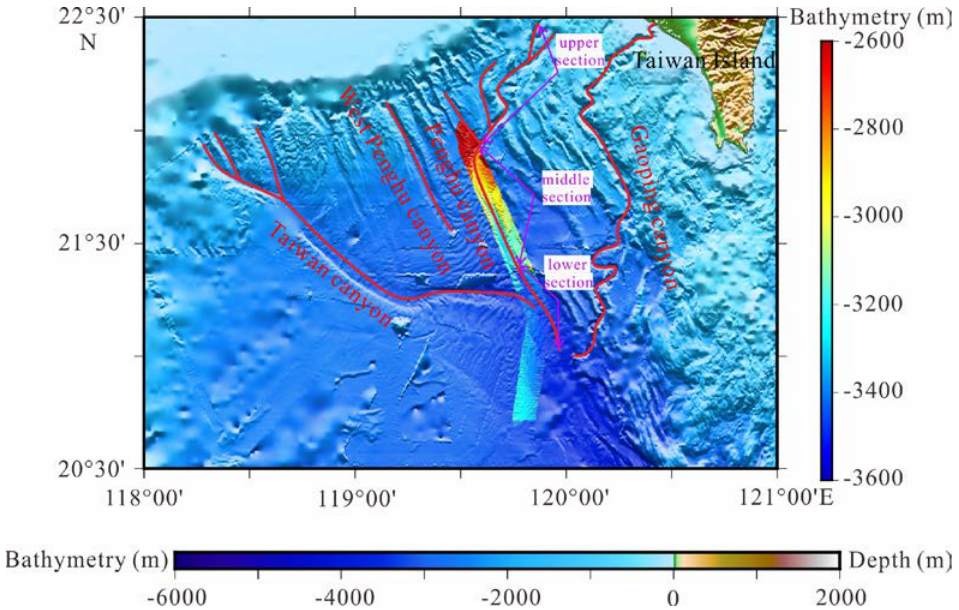
Figure 2. Multibeam bathymetric map of the Taixinan canyon groups. The bottom map is drawn using GEBCO-2021 bathymetry data (https://www.gebco.net/data_and_products/gridded_bathymetry_data/ (accessed on 15 August 2021)), and the color bar is below the image. The Penghu canyon is shown in the new bathymetry data collected in 2020 by “Dongfanghong 3” research vessel, and the color bar is on the right of the image. The red lines represent the canyon axis. The Penghu canyon is divided into the upper, middle, and lower sections based on water depth and canyon profile morphology. The Penghu canyon extends downward to intersect with the Taiwan canyon and links with the Manila Trench to the south.